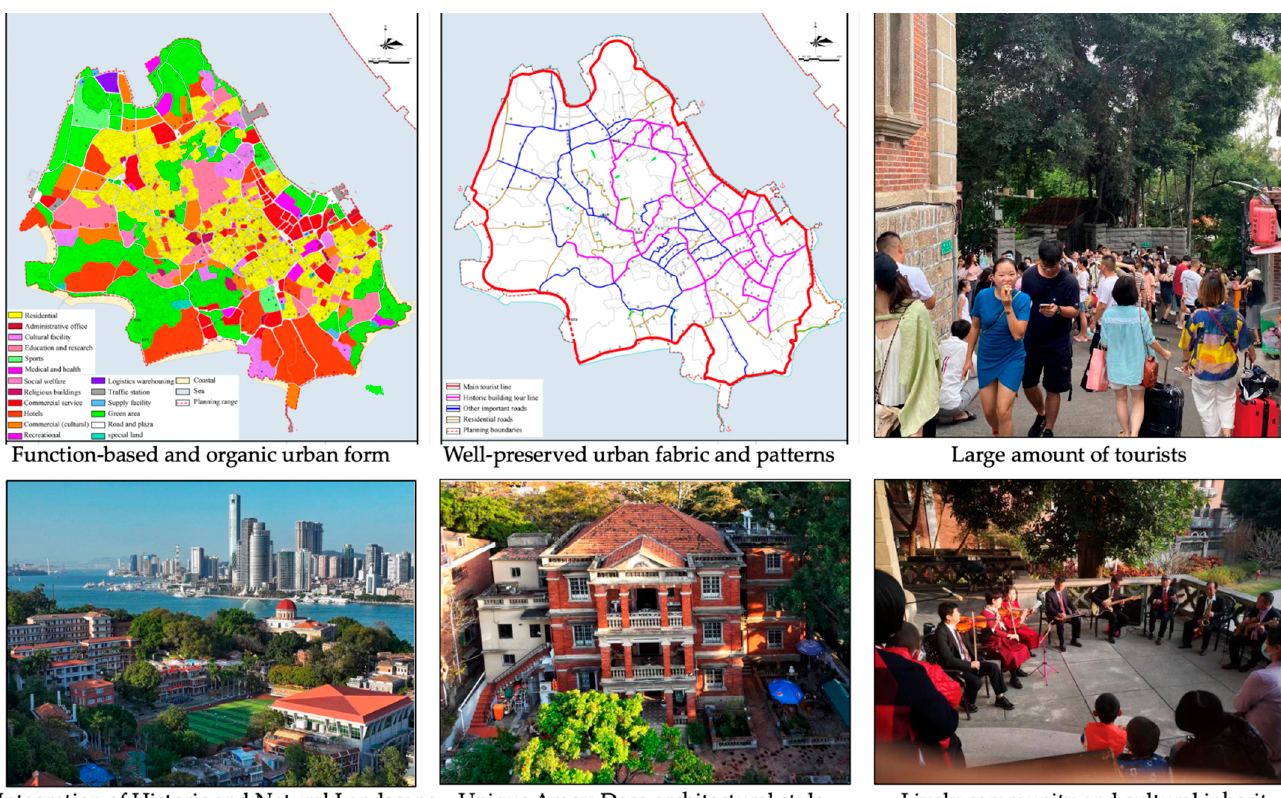
Figure 2. The urban morphology, architecture typology, landscape view, tourists flow, and local community cultural events. Source: Xiamen Urban Planning and Design Institute and Songrong Cai from Kulangsu World Cultural Heritage Monitoring Center.